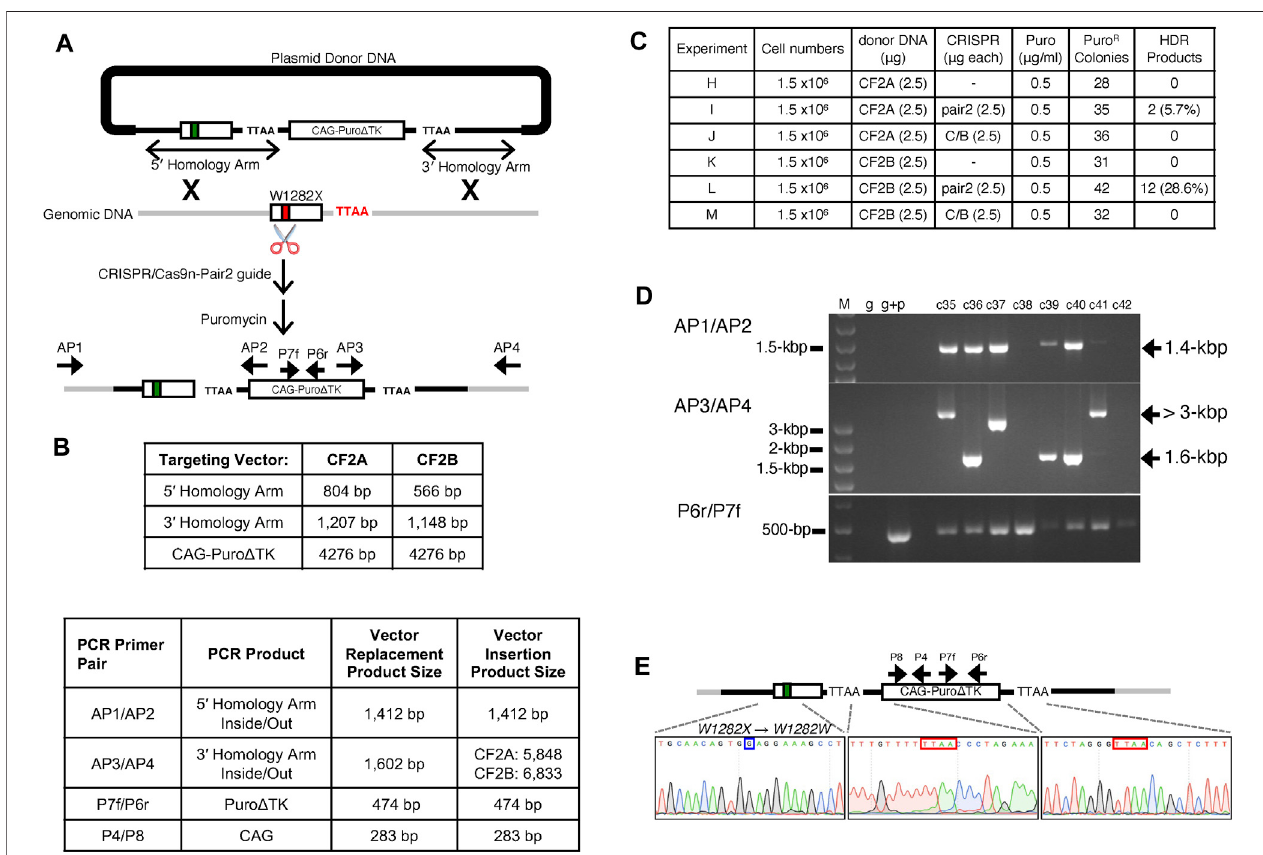
FIGURE 2 | CharacterizationofVectorReplacementEventsinCF2-iPS3Cells (A) Illustrationoftargetingstrategy via HDRwithdonorDNAcarrying Puro Δ TK cassette,describedin methods.PCRprimers(AP1/AP2,AP3/AP4,andP6r/P7f)usedtocon fi rmsuccessfulHDRareillustratednexttotheannealingsites.AP1/AP2;intronatupstreamof CFTR exon23through the5 ′ endofthe Puro Δ TK cassette.AP3/AP4;3 ′ endof Puro Δ TK cassettethroughintronatdownstreamofexon23.P6r/P7f;PuromycinresistantgeneatPuro Δ TKcassette.Inthis fi gureand subsequent fi guresthemediumblacklinerepresentsvectorDNAsequenceshomologoustotheexon23region,greylinesrepresentgenomicDNAandtheheavyblacklinerepresents plasmidbackboneDNAsequence.Exon23isrepresentedbyanopenrectanglewiththe W1282X allelerepresentedbyaredboxandthe W1282X -wtcorrectedalleleisrepresentedbya greenboxintheexon23rectangle. (B) Homologyarm,Puro Δ TK,anddiagnosticPCRampliconlengths. (C) ExperimentaltransfectiondetailsfordrugselectionsandHDRef fi ciencies. (D) HDR productsasassayedbyPCRarealsoshowninSupplementalmaterials SupplementaryFigureS3 ,withagarosegelpicturesforrepresentedcolonies.M;1 kbor100 bpDNAladderplus, g; CF2-iPS3 genomic DNA, g + p; the mixture of CF2-iPS3 genomic DNA and donor DNA. High molecular weight (HMW) fragments ( > 3 kbp) observed in AP3/AP4 PCR were further investigated in Figure 4 , and Supplementary Figures S5, S6 . (E) Sequence chromatogram showing the 5 and 3 ′ junctions of the Puro Δ TK cassette (shown in red box) and W1282X mutationsitein CFTR exon23(showninbluebox)intheIc8clone.SangersequencingwasperformedonAP1/AP2andAP3/AP4ampliconstosequenceonlytargetedallelesequences.